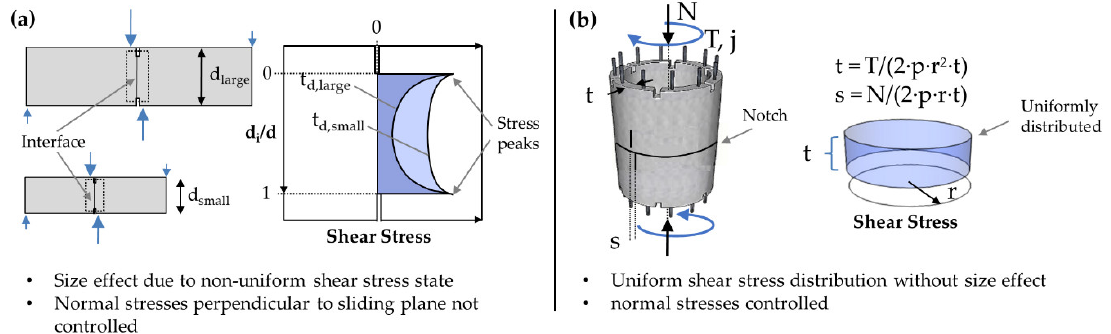
Figure 15. Comparison of shear profiles in the test zones of the ( a ) conventional notched rectangular shear test specimen and ( b ) tubular twisted specimen with uniform shear profile in the circumferential direction.